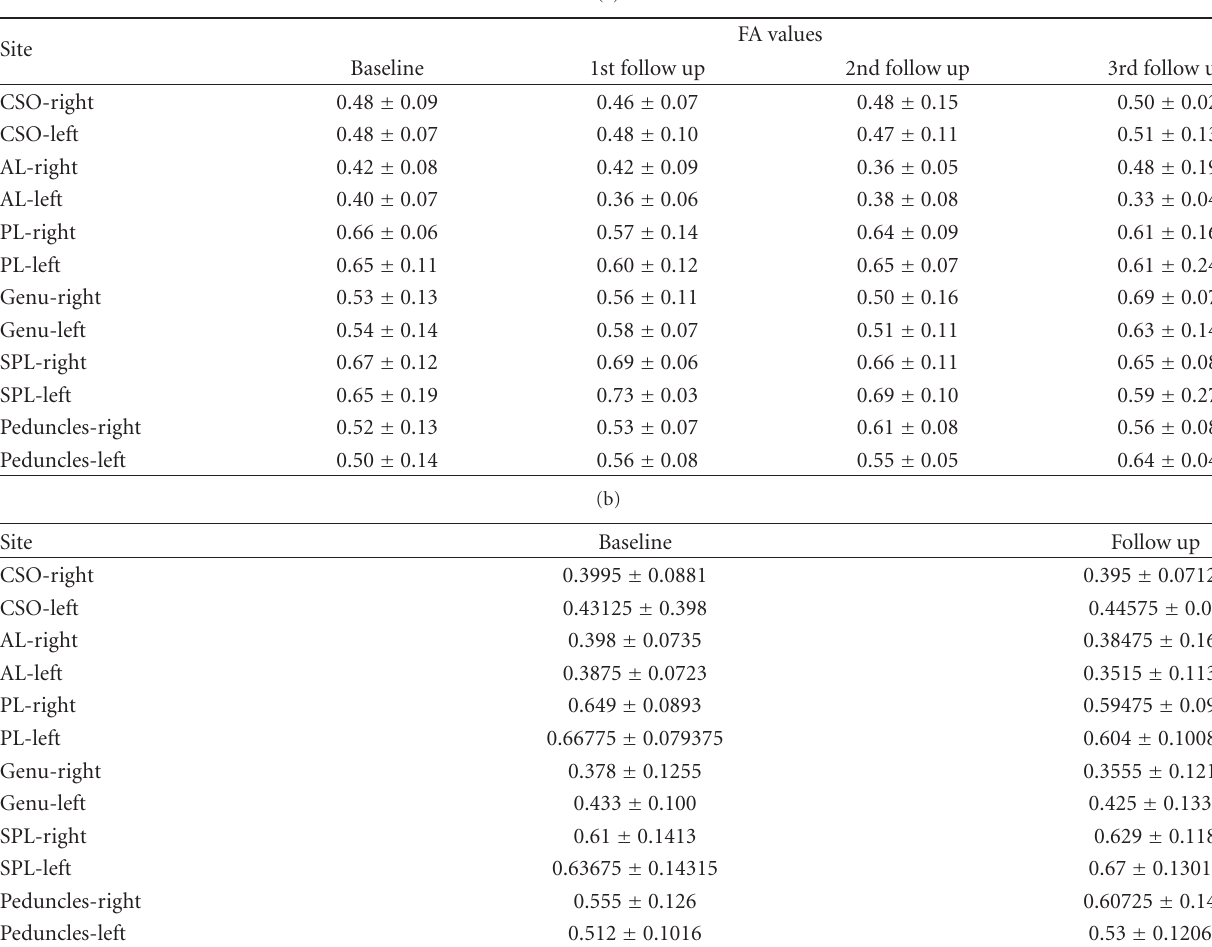
Table 3: MR tractography: (a) Average ± SD of Levels of fractional anisotropic values (FA) in 12 di ff erent sites in brain of PD patients. (b) Average ± SD of Levels of fractional anisotropic values (FA) in 12 di ff erent sites in brain of PD plus